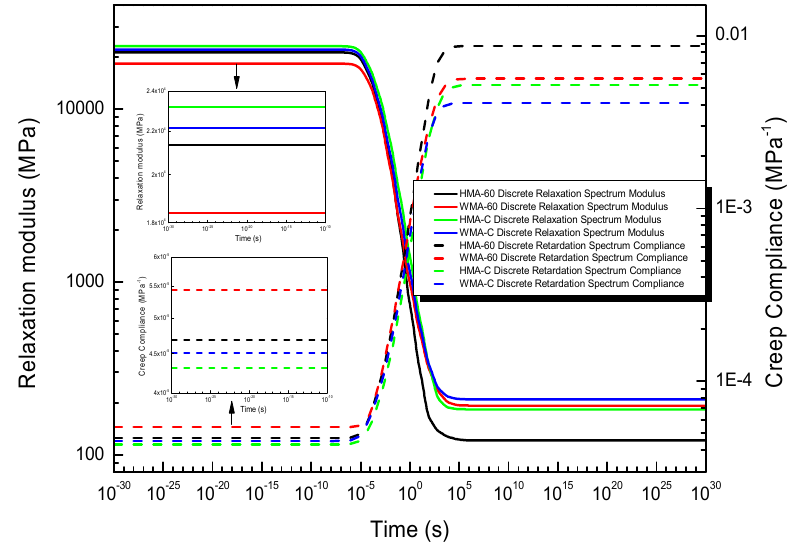
Figure 10. The relaxation modulus and creep compliance obtained from the discrete spectrum.